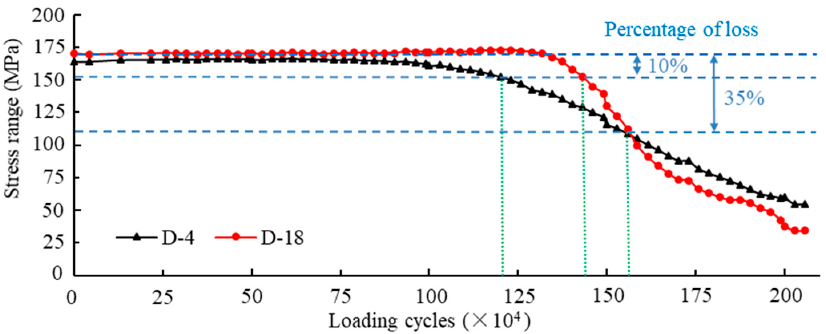
Figure 7. Stress ranges measured at the two crack-initiate sites in TEU-10.